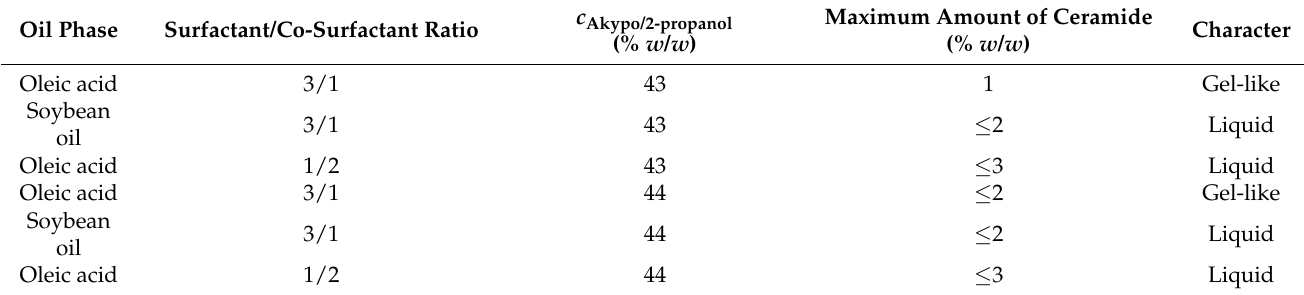
Table 2. Summary of the maximum amount of ceramide-like molecule that can be solubilized within O/W microemulsions with fixed surfactant/co-surfactant ratio and concentration, and oil content of 3% w / w . Oil